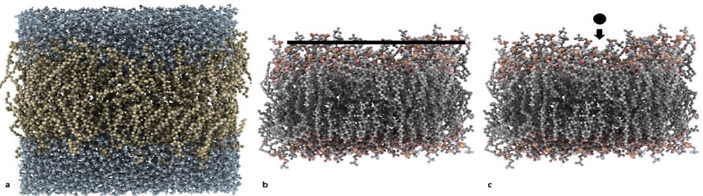
Figure 1. ( a ) Hydrated 1,2-dipalmitoyl-sn-glycero-3-phosphocholine (DPPC):cholesterol (CHOL) bilayer used in phase I and phase II Steered Molecular Dynamics (SMD) set 1 simulations; ( b ) setup for phase I simulations (the disaccharide layer is shown as a black line, and the water molecule is not shown); and ( c ) setup for phase II SMD set 1 simulation (the black dot represents the disaccharide pulled from bulk water into the bilayer, and the water molecule is not shown).